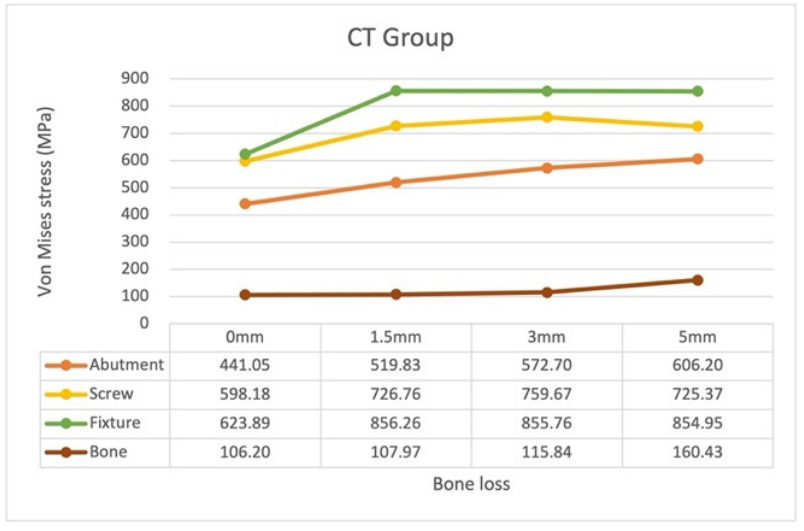
Figure 10. Maximum von Mises stress on the abutment, screw, fixture, and bone in the CT groups with different bone loss levels.